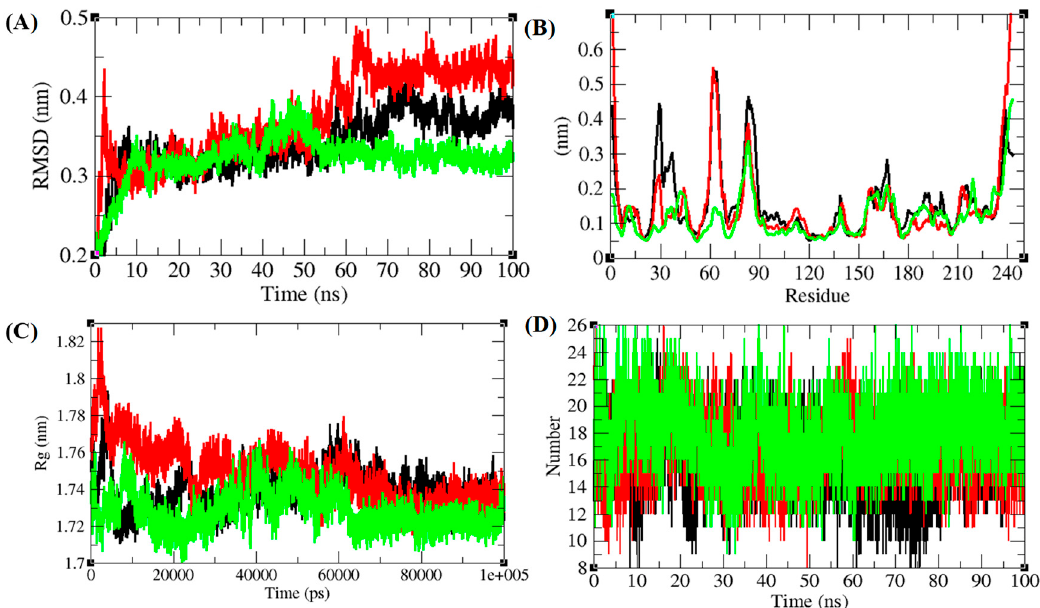
Figure 6. The structure nonconformities and residual variations of TmPLB1. ( A ) RMSD (Root mean square deviation) of TmPLB1 respect with time. ( B ) The backbone residues fluctuations (RMSF) of TmPLB1. ( C ) Radius of gyration ( Rg ) calculated the compactness of TmPLB1. ( D ) H-bonds shown amongst main chain plus side chain of TmPLB1. The black, red and green colors were representing the respective temperatures at 30 °C, 35 °C, and 40 °C, respectively.